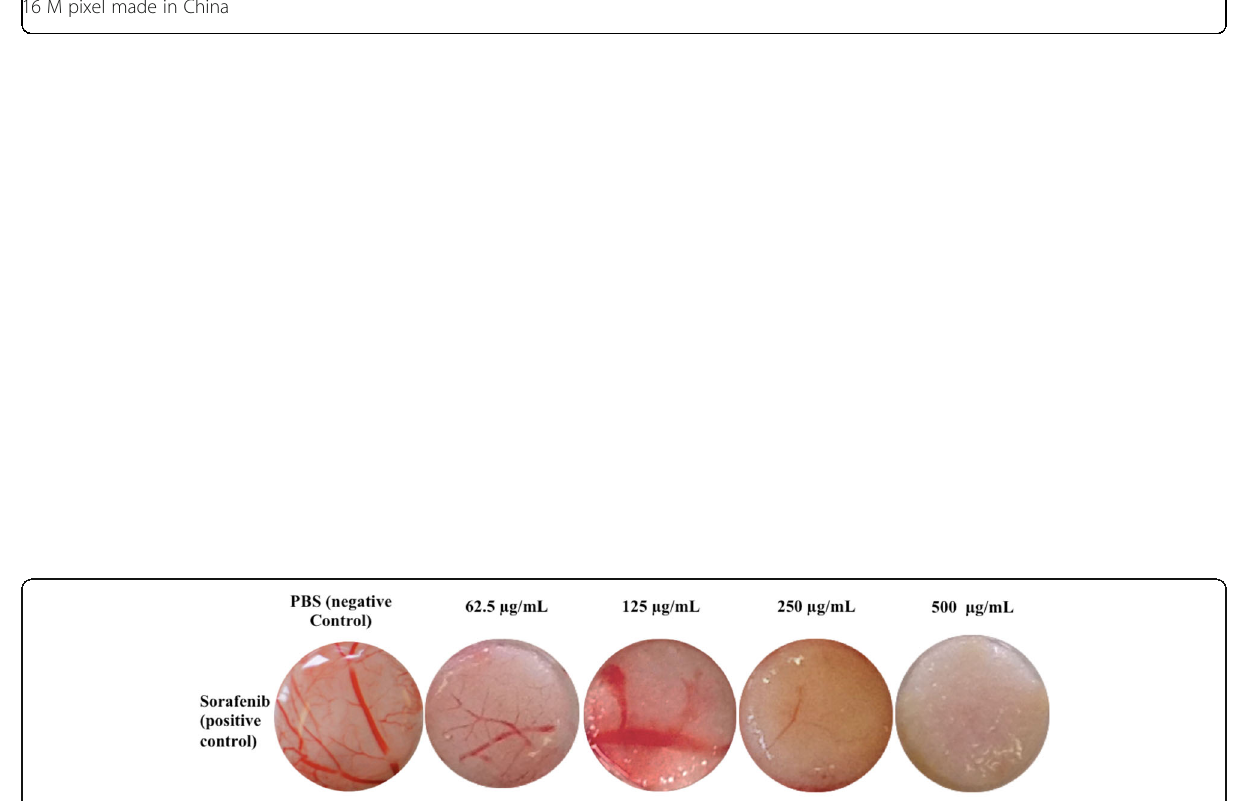
Fig. 1 Shrub and trunk of S. ochocoa. Photos taken at Mitzic, Woleu-Ntem (Nothern of Gabon) by Ngoua-Meye-Misso with digital camera Cannon